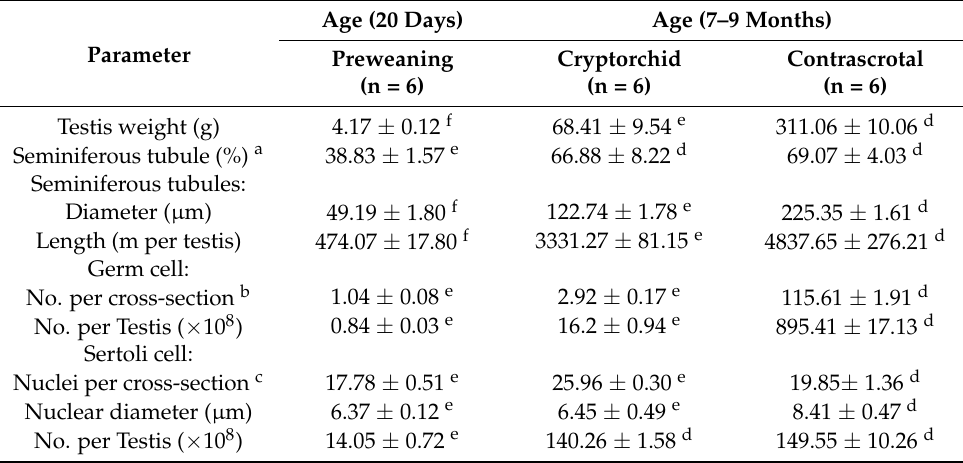
Table 1. Quantitative data regarding the main testicular structures in boars in the preweaning, cryptorchid and contrascrotal groups. The results represent mean ± SD.